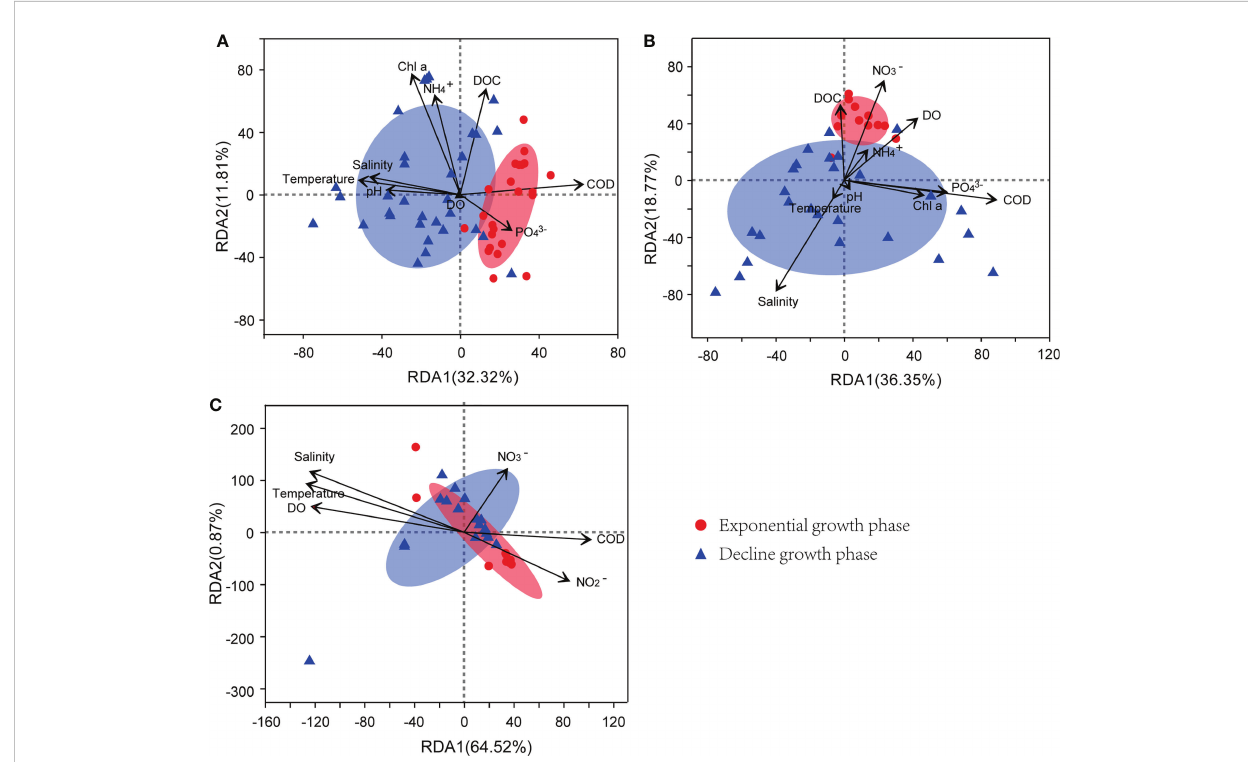
FIGURE 8 RDA of environmental factors and bacterial community structure from bacterioplankton (A) , particle-attached bacteria (B) , and colony-attached bacteria (C) . E, exponential growth phase of Phaeocystis globosa bloom; D, decline growth phase P. globosa